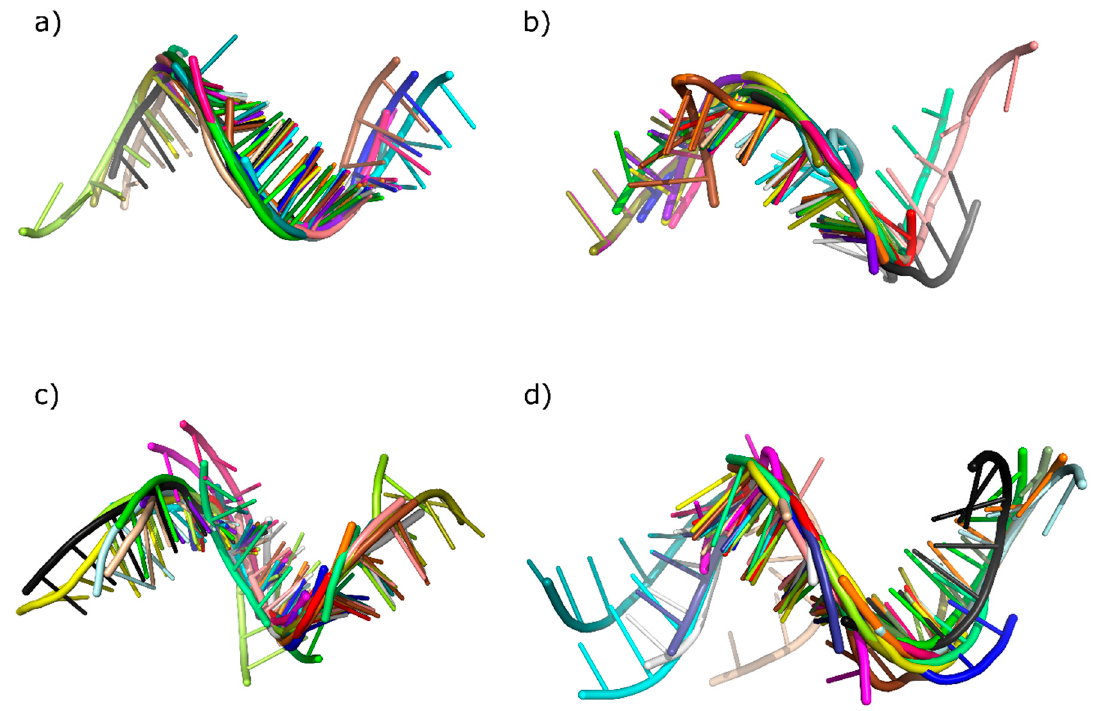
Figure 4. Aligned three-dimensional (3D) substructures within each phylum: ( a ) Chlorophyta , ( b ) Coniferophyta , ( c ) Embryophyta , and ( d ) Magnoliophyta .